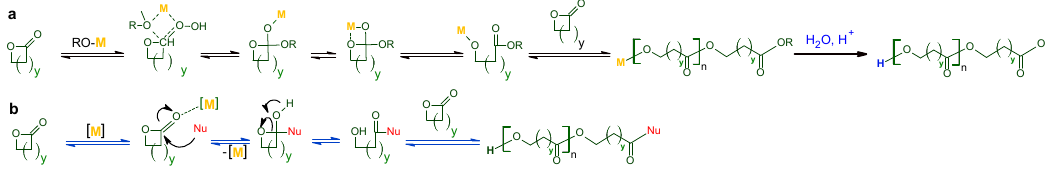
Figure 5. Mechanism of ROP of lactones using organometallics [M] as ( a ) an initiator in the “coordination-insertion” mechanism and ( b ) as a catalyst in the presence of nucleophiles (Nu) [10].